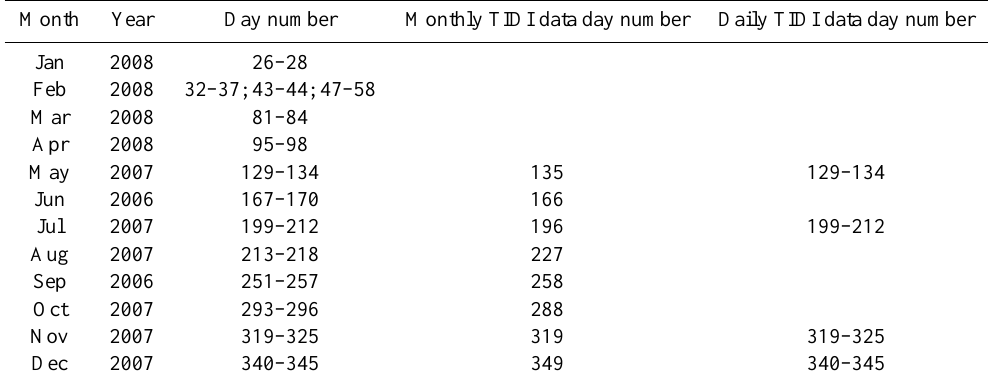
Table 2. JASMET observations and comparison with TIDI.